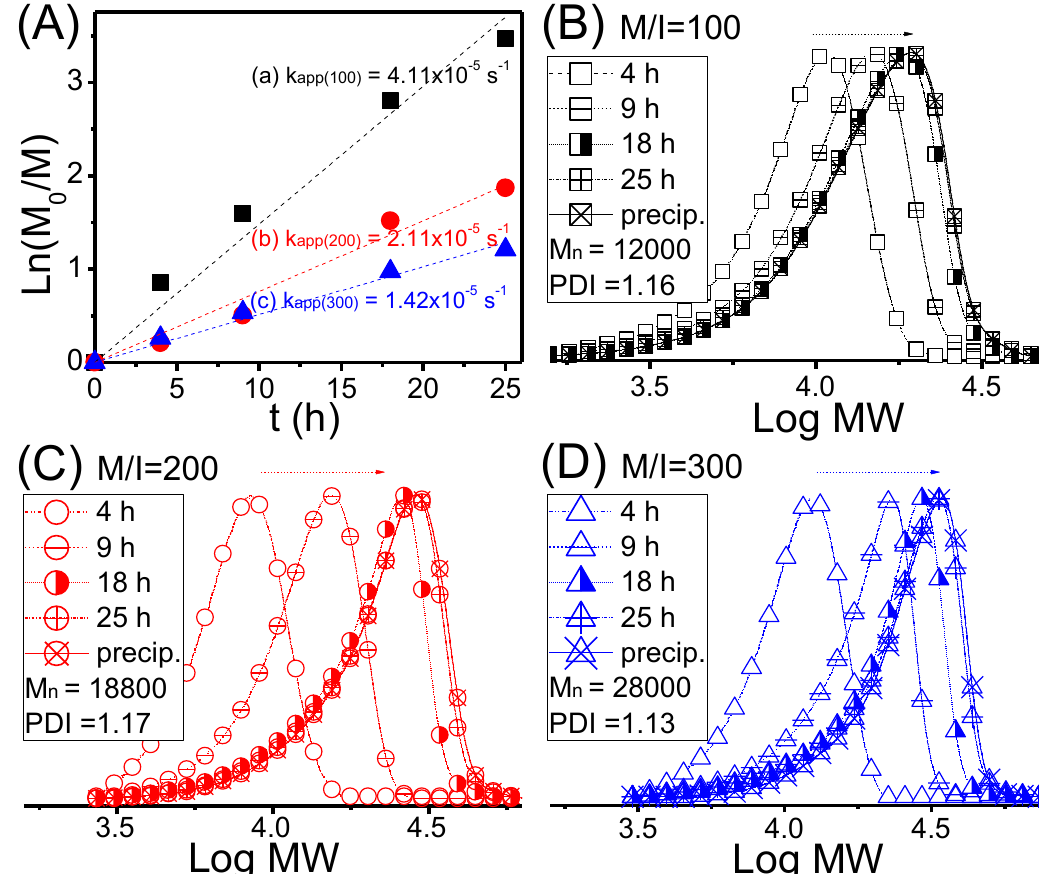
Figure 4. ( A ) Kinetic plots of surface-initiated initiators for continuous activator regeneration atom transfer radical polymerization (SI ICAR ATRP) of methyl methacrylate (MMA) (MMA/EBiB/CuBr 2 /PMDETA/AIBN = x /1/0.05/0.1/0.5 at 70 °C; [MMA] 0 = 2.0 M in anisole) where x = ( B ) 100, ( C ) 200, and ( D ) 300.